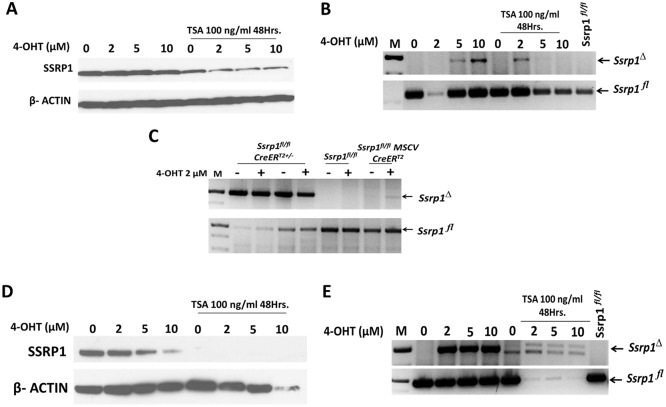
Effect of TSA on Ssrp1fl excision by ectopic and germline CreERT2.A) Immunoblot of SSRP1 protein expression in transformed Ssrp1fl/fl MSCV CreERT2 cells with or without 4-OHT and TSA treatment. B) PCR of genomic DNA of transformed Ssrp1fl/fl MSCV CreERT2 cells with or without 4-OHT and TSA treatment. C) PCR of genomic DNA of immortalized Ssrp1fl/fl
CreERT2+/- with or without 2 μM 4-OHT treatment for 120 h. D) Immunoblot of SSRP1 protein expression in immortalized Ssrp1fl/fl
CreERT2+/- cells with or without 4-OHT and TSA treatment. E) PCR of genomic DNA of immortalized Ssrp1fl/fl
CreERT2+/- cells with or without 4-OHT and TSA treatment.